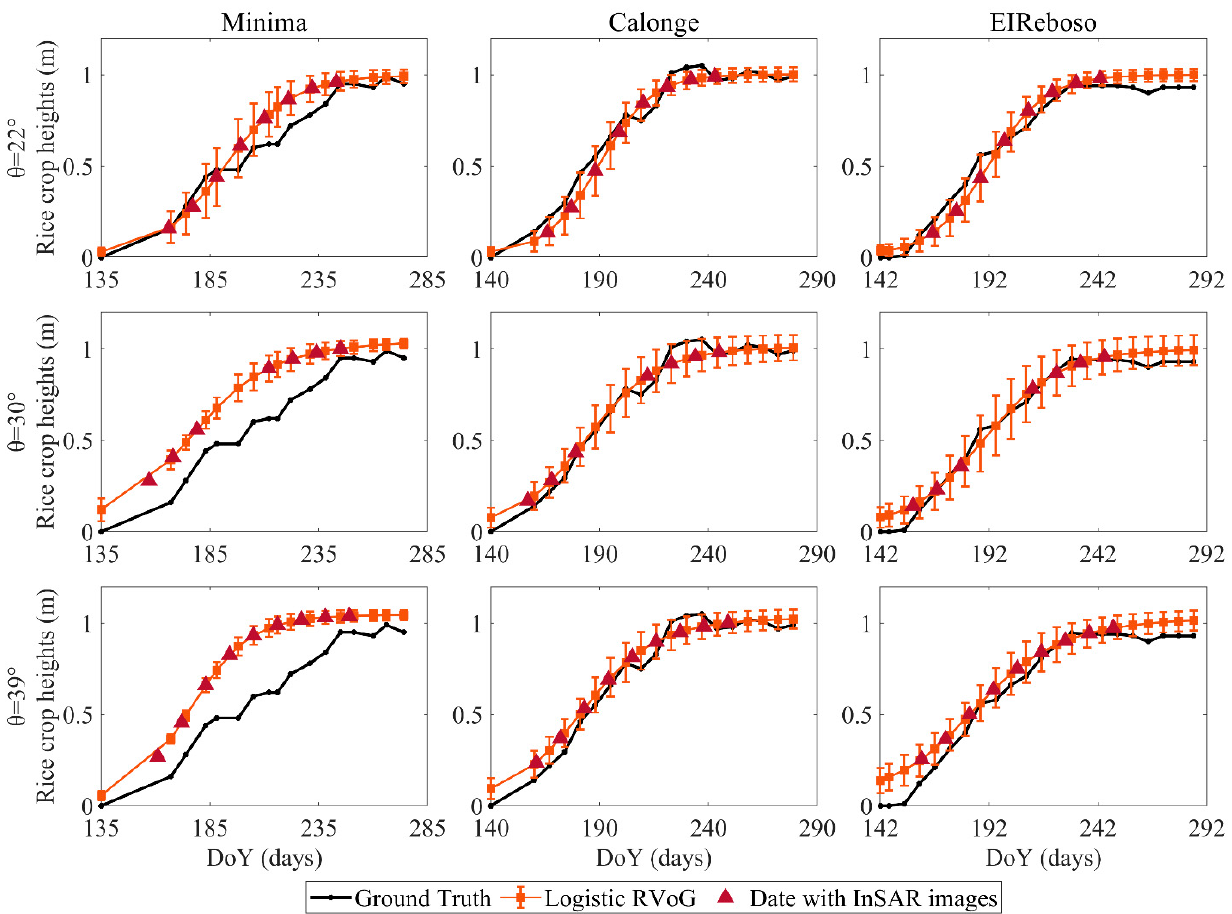
Figure 9. Variation in the crop height considering the proposed date selection. The dates with InSAR observations (red triangles) are introduced to calculate the parameters of the equations and the rice height estimations. The predictions obtained from the proposed approach (orange) are compared to the ground-truth data (black). The columns from left to right show the results for the three monitored rice plots in Seville for incidence angles of 22°, 30°, and 39°. The average results computed for all the pixels inside each plot on days with ground-truth data are presented. The error bars denote the standard deviation within each plot.